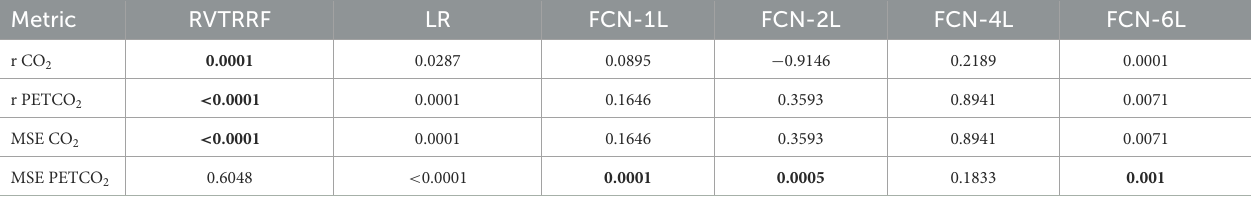
TABLE 2 Statistical comparison of various approaches and network structures with FCN-4L-Wgt.